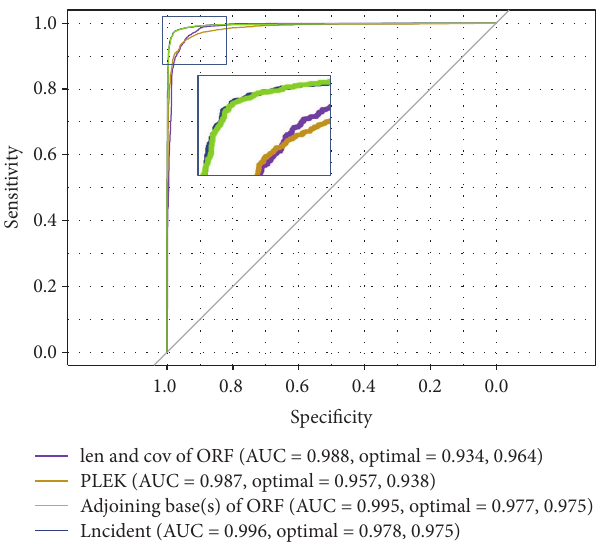
Figure 3: The Receiver Operating Characteristic (ROC) curve of several feature